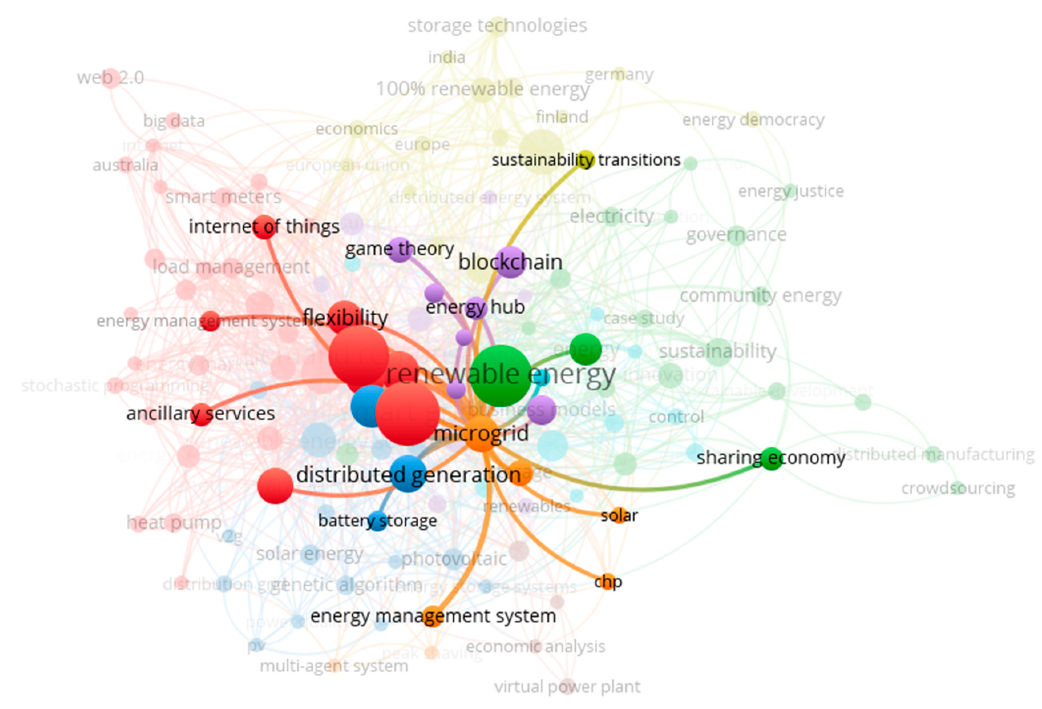
Figure 15. Highlighting the connections around ‘microgrid’.